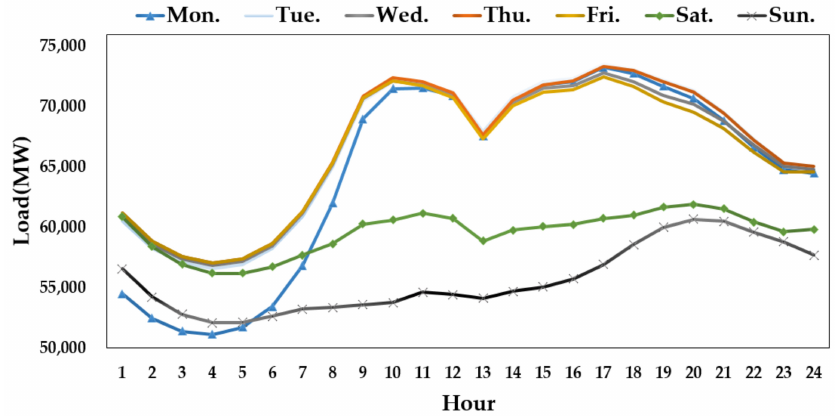
Figure 2. The average electric load pattern by day of the week in 2019.